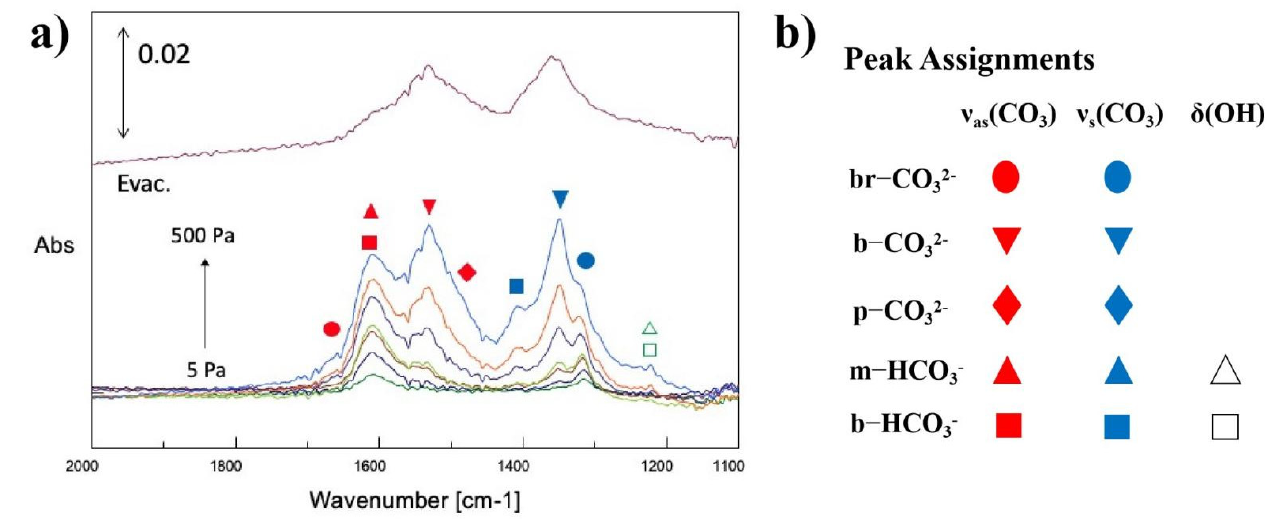
Figure 5. ( a ) The FTIR spectra of the dark adsorption on the Pd 2 Cu/P25 photocatalysts and ( b ) peak assignments at various pressure gradients from 5 Pa to 500 Pa of CO 2 vapor and finally in vacuum condition.